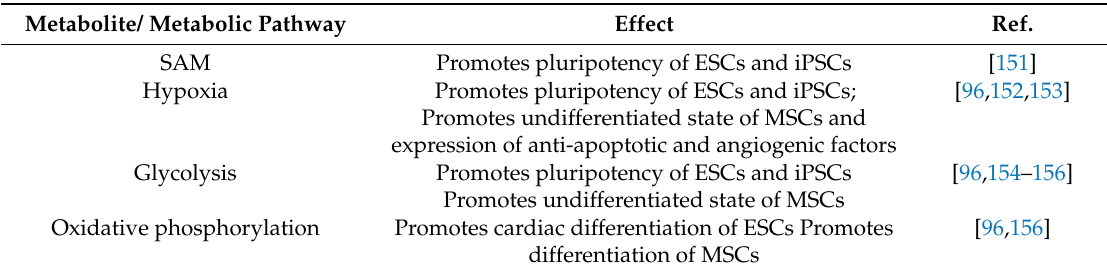
Table 5. Regulation of SC fate by metabolites/ metabolic pathways. Metabolite/ Metabolic